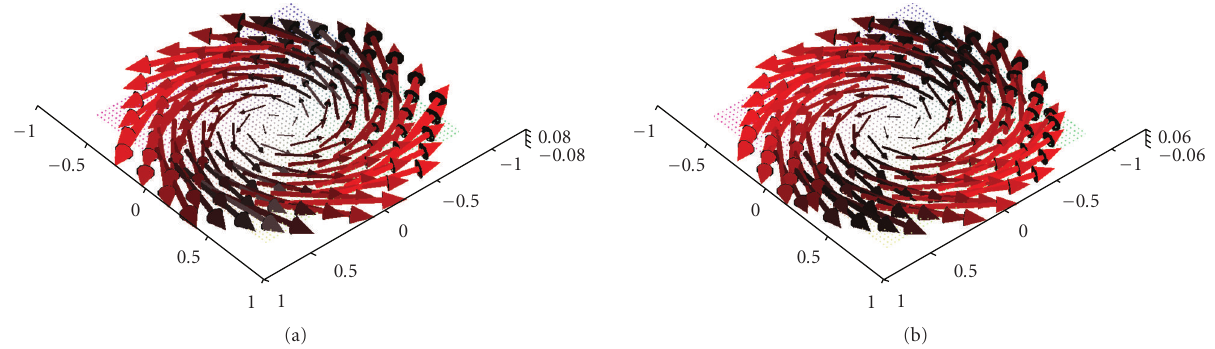
Figure 3: (a) Original vector field f ( x ) = ( − x 2 , x 1 ,0) (cid:9) . (b) Reconstruction with the described algorithm for γ = 0 . 00692 using exact, simulated data D 1 f .